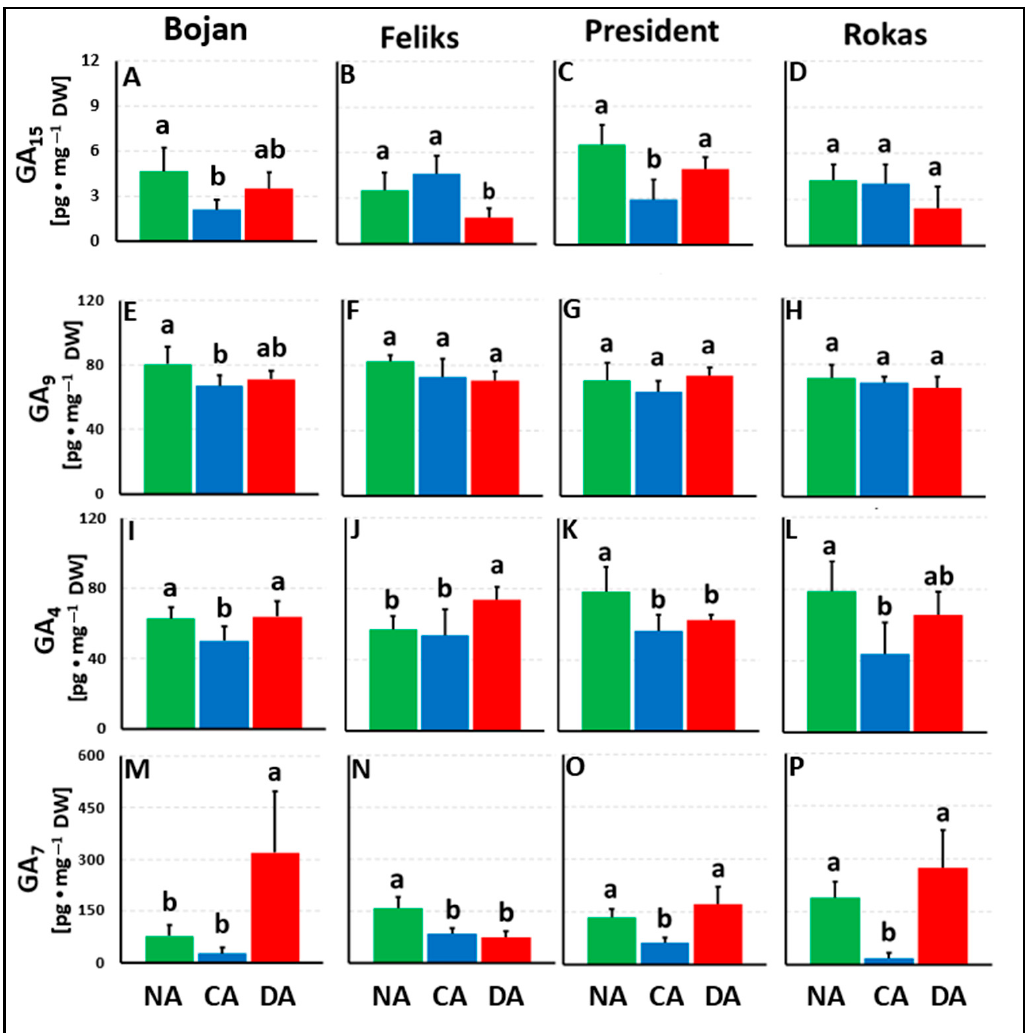
Figure 2. Content of the gibberellins GA 15 , GA 9 , GA 4 and GA 7 in four cultivars of the non-acclimated (NA), cold-acclimated (CA) and deacclimated (DA) oilseed rape. The gibberellins are presented in order based on the biosynthetic pathway from the precursor GA 15 via GA 9 to their active forms GA 4 and GA 7 (according to [33]). ( A – D )—GA 15 ; ( E – H )—GA 9 ; ( I – L )—GA 4 ; ( M – P )—GA 7 . Values marked with the same letters (within each cultivar separately) were not significantly different according to the Duncan test ( p ≤ 0.05).